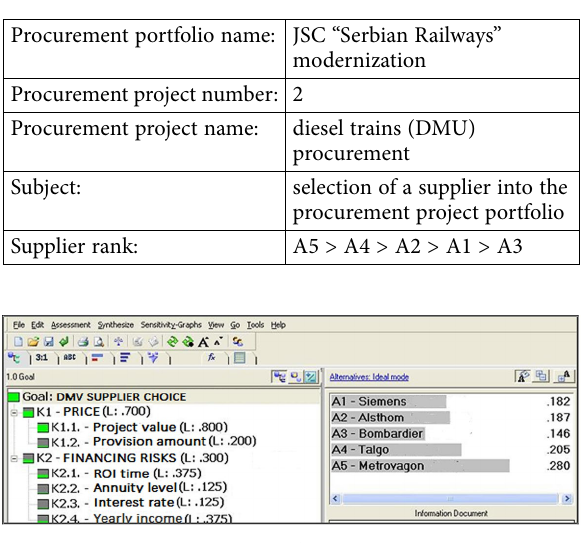
Figure 5. Weighted coefficient supplier ranking